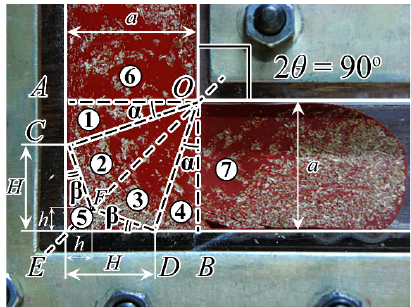
Figure 4. Physical model of the shape of material dead zone CEDF during ECAE through a Segal 2θ -die with channel intersection angle 2θ=90° .